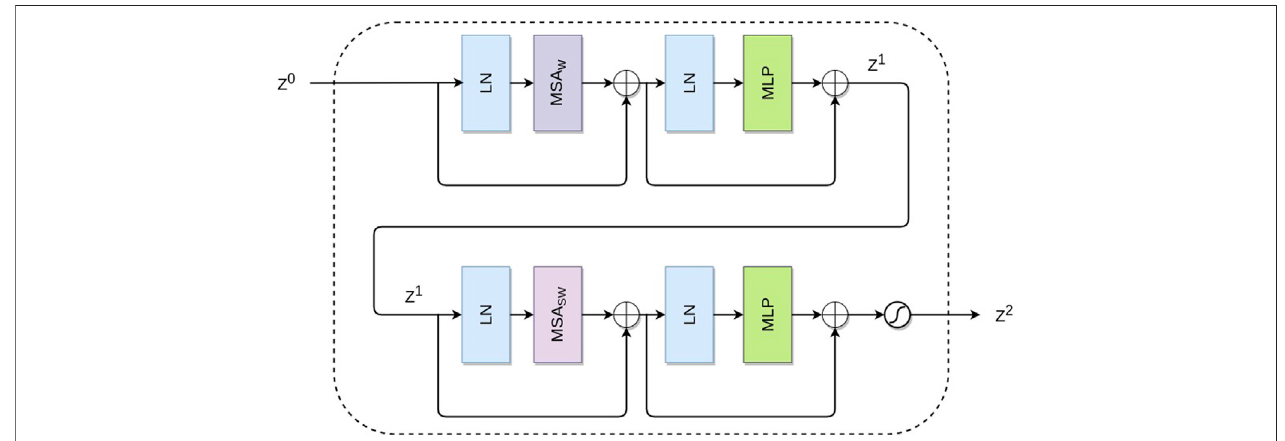
FIGURE 2 | Our proposed cascaded transformer guidance